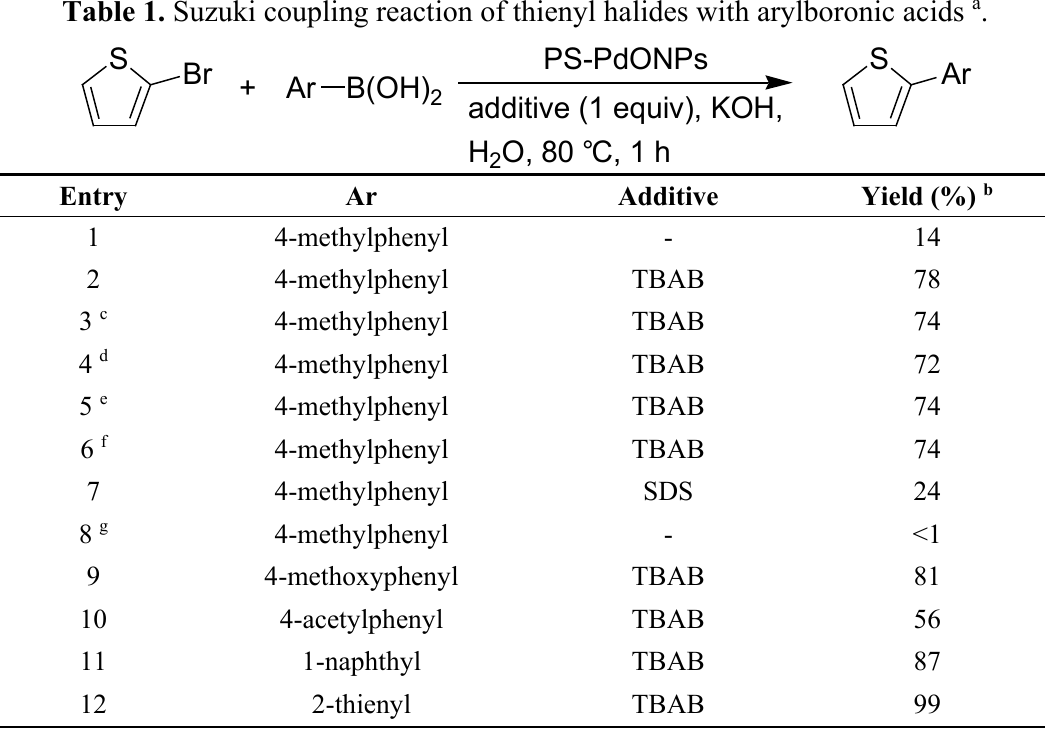
Table 1. Suzuki coupling reaction of thienyl halides with arylboronic acids a